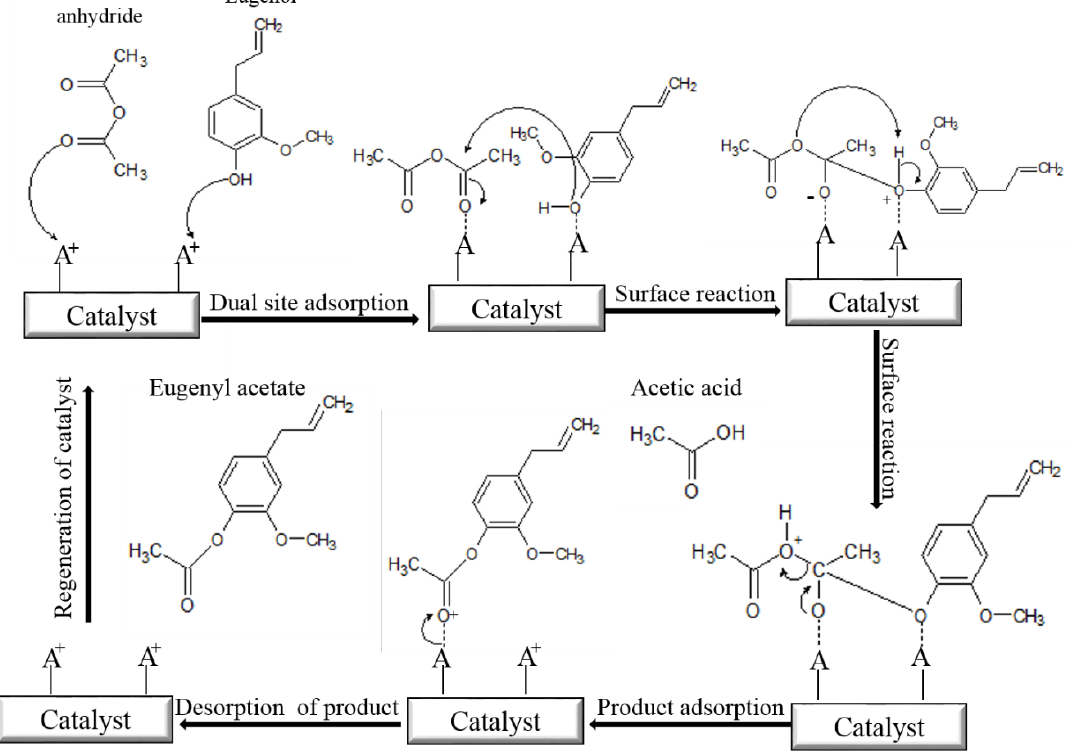
Scheme 1. Proposed mechanism for eugenol acetylation reaction on solid acid catalyst